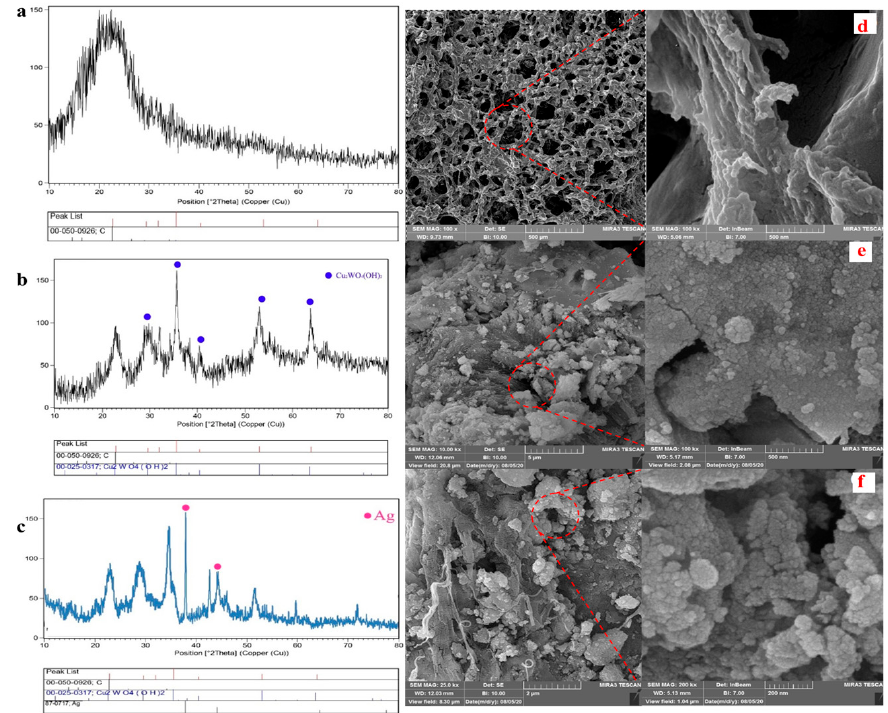
Figure 1. XRD patterns and FESEM images of the ( a , d ) spongin, ( b , e ) spongin-Cu 2 WO 4 (OH) 2, and ( c , f ) spongin-Cu 2 WO 4 (OH) 2 @AgNPs.